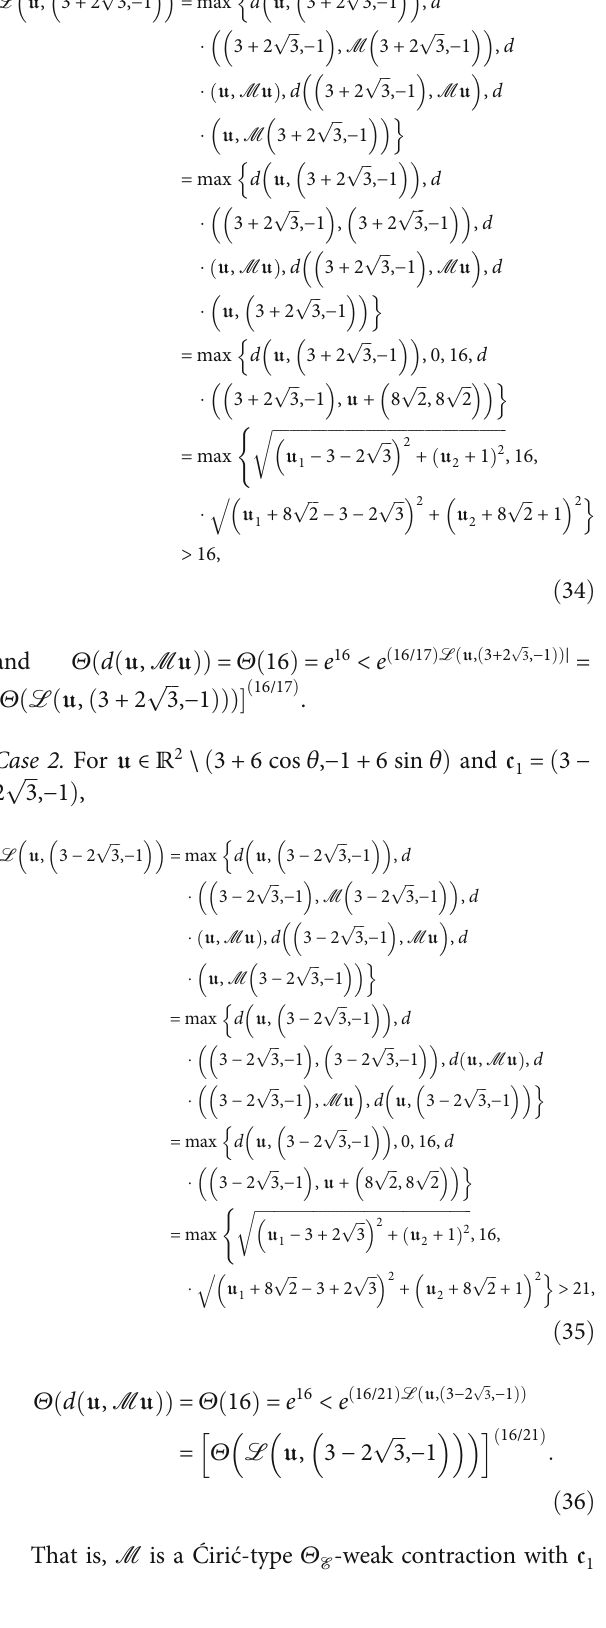
, c , 8 ÞÞ , respectively, which is 1 2